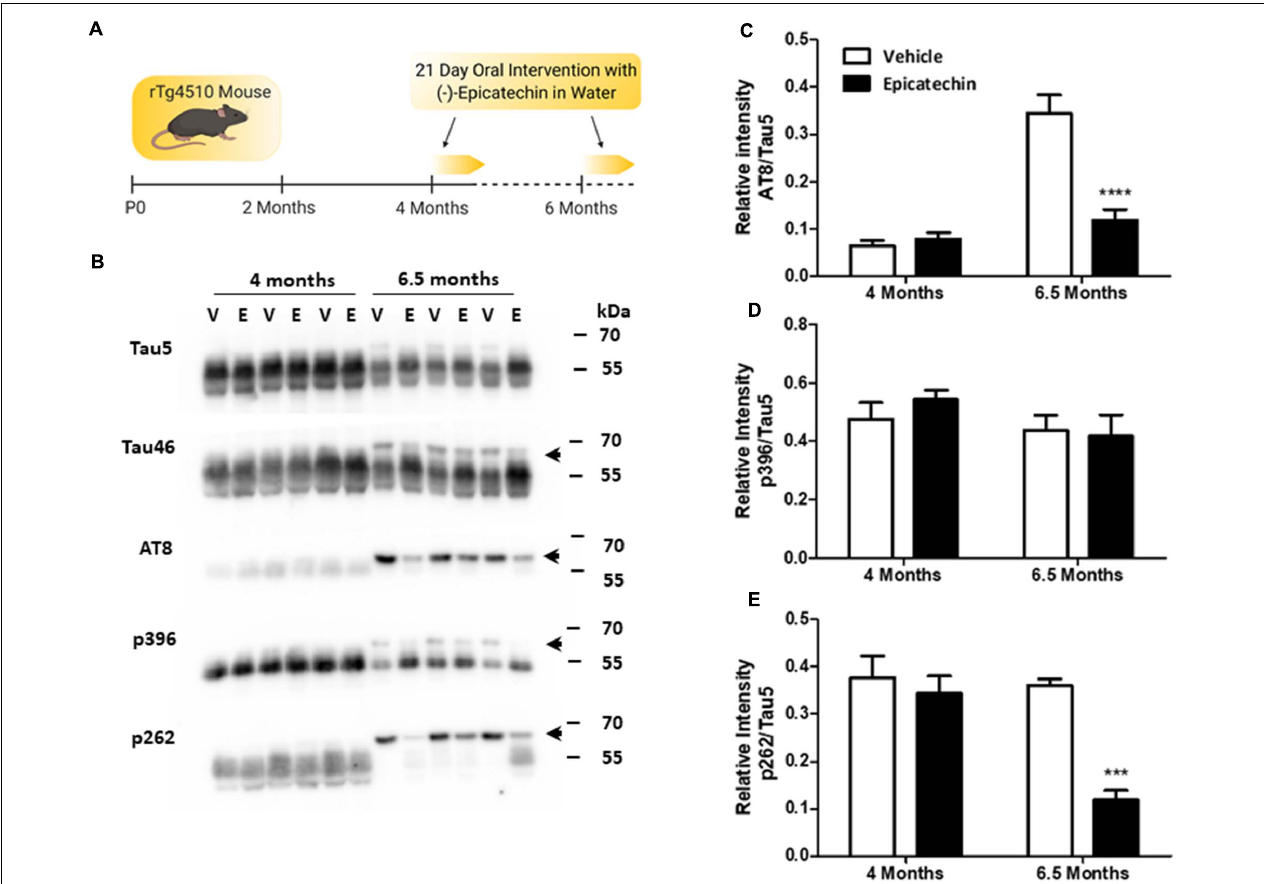
FIGURE 1 | ( − )-Epicatechin inhibits age-dependent tau phosphorylation in rTg4510 mice. (A) Schematic summarizing the ( − )-epicatechin (EC) dosing regime. rTg4510 male mice at 4 and 6.5 months of age were given free access to drinking water supplemented with either EC (3 mg/ml) or vehicle (0.1% ethanol) for 21 days. (B) Immunoblots of whole brain homogenates (20 µ g) from 4 and 6.5 month old mice exposed to either vehicle (V) or EC (E) probed with antibodies against full length Tau (Tau 5 and Tau 46), the dual phosphorylation sites Ser202/Thr205 (AT8), phosphorylation at Ser396 (p396), and phosphorylation at Ser262 (p262). The arrow indicates the higher molecular weight band at ∼ 64 kDa. (C–E) Quantification of changes in levels of phosphorylation status as a ratio of total Tau (Tau 5). Vehicle (Clear bars), EC (Black bars). Data presented is mean of relative intensity ± SEM ( n = 5). *** p < 0.001; **** p < 0.0001. Schematic created with